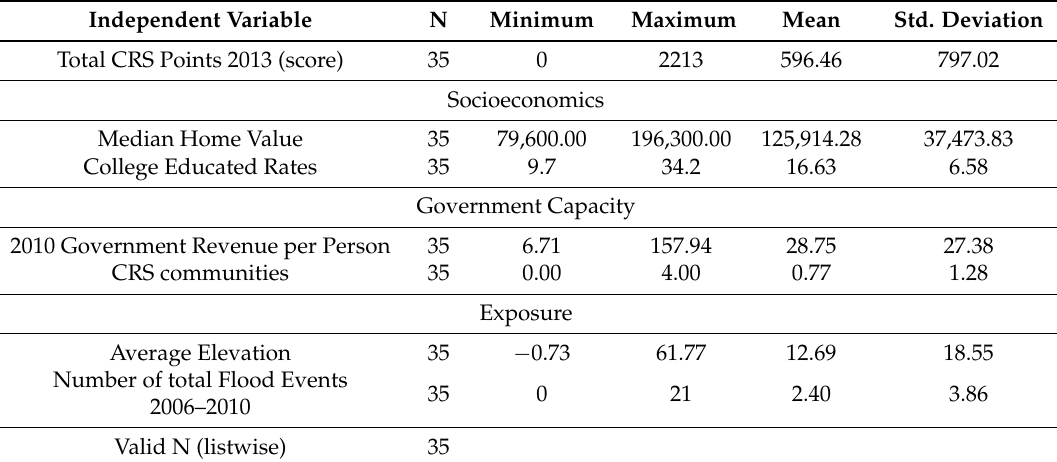
Table 5. Independent variables’ descriptive statistics.